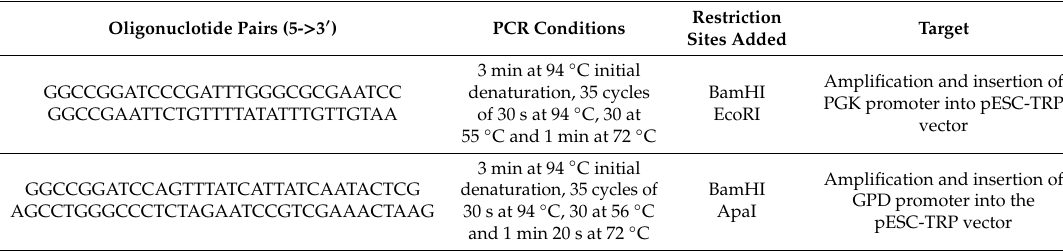
Table 1. Oligonucleotides used for the expression of recombinant 4CL1 from Plagiochasma appendiculatum and six STS from di ff erent plant